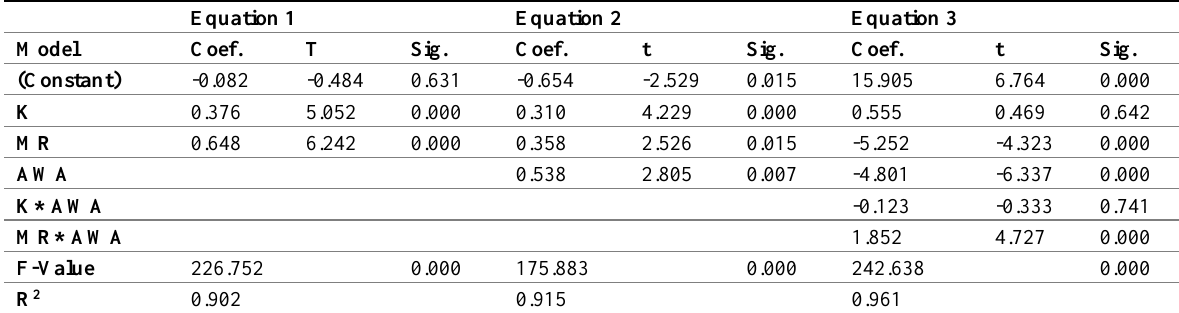
Table 6: Hypothesis Testing Results